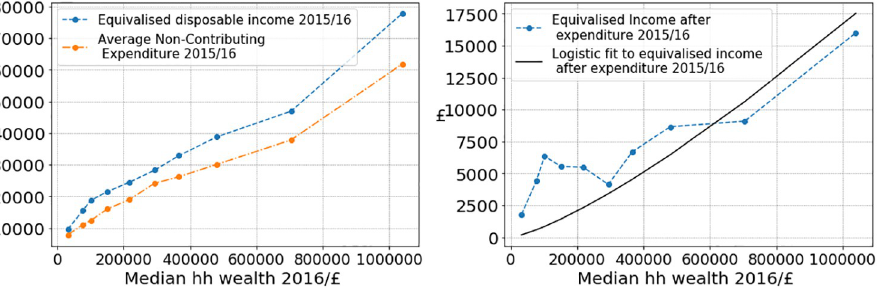
Fig 5. Left: Plot of equivalised disposable income and average household expenditure for 2015/16 against 2016 median wealth deciles. Right: Fit of the logistic function (11) to equivalised disposable income after expenditure, where we choose κ 1 = 10 6 and fit κ 2 = 4.13 � 10 9 and κ 3 = − 1.308. ONS data sources used can be found in [32,